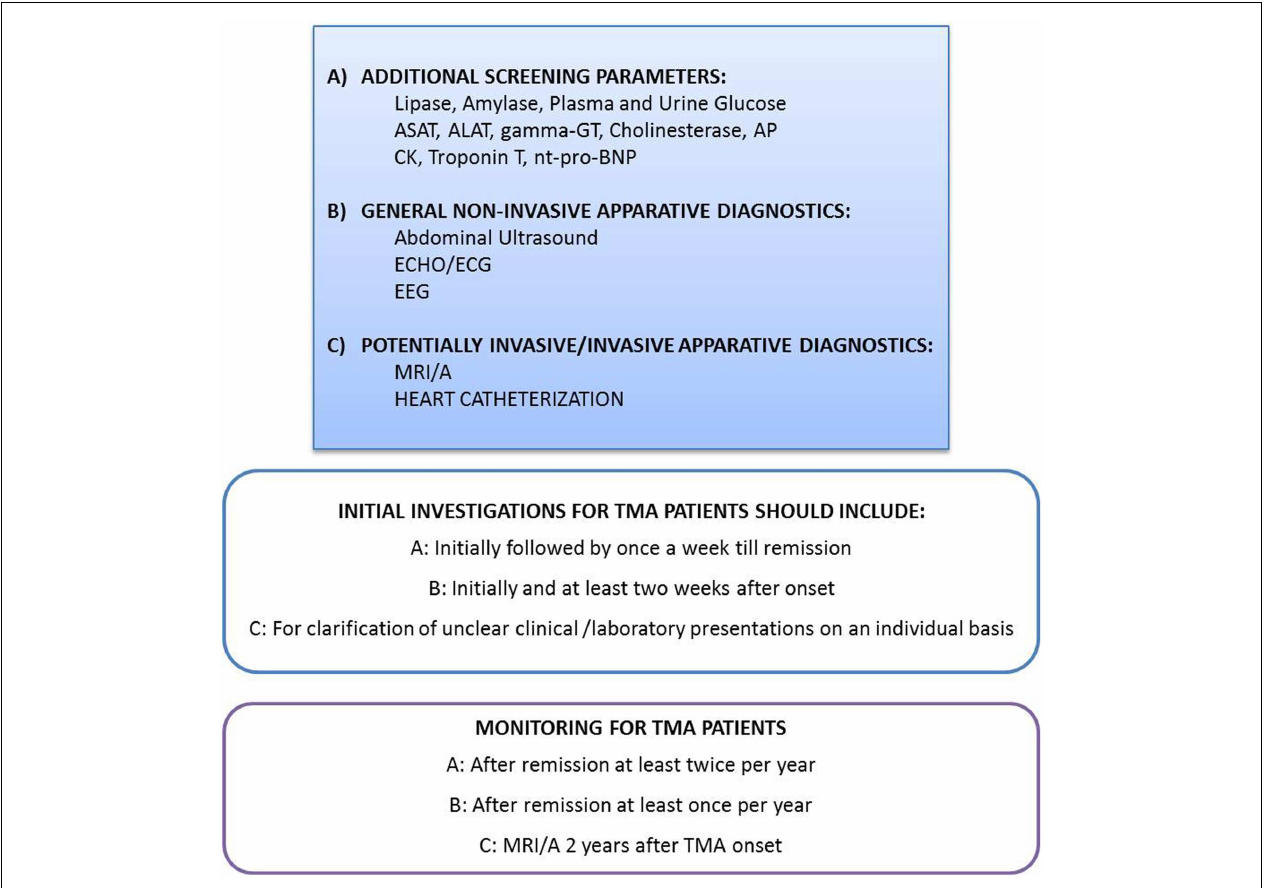
children with the need of total anesthesia have to be proven on an individual basis.The recommendation for MRI/A 2years after onset in all patients with complement-mediatedTMA excludes children with the need for total anesthesia, except those with clinical cerebrovascular symptoms. ALAT, Alanin-aminotransferase; AP, alkaline phosphatase; ASAT, aspartat-aminotransferase; CK, creatine kinase; ECG, electrocardiography; ECHO, echocardiography; EEG, electroencephalography; gamma-GT, gamma-glutamyl transpeptidase; MRI/A, magnetic resonance imaging/angiography; nt-pro-BNP, N-terminal pro brain natriuretic